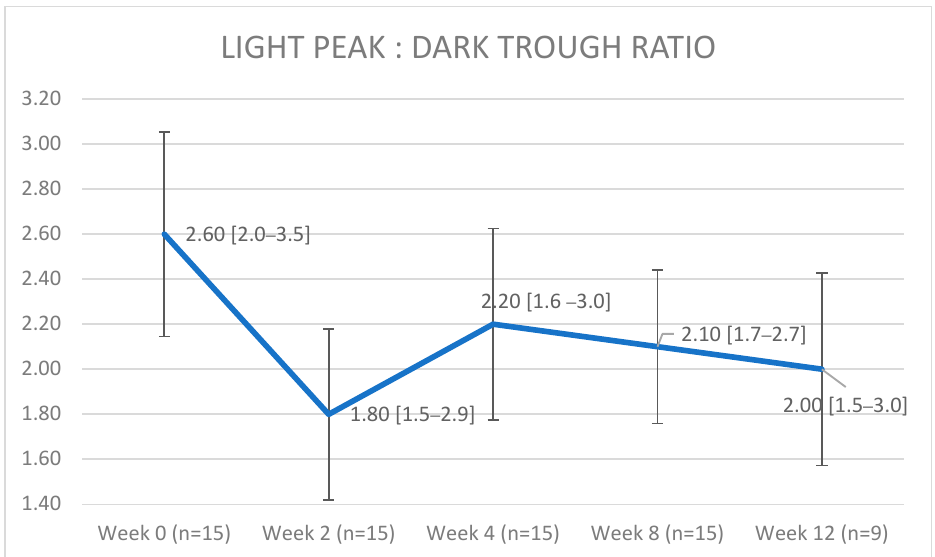
Figure 3. A visual representation of the light peak:dark trough ratios shows a dramatic decrease after the initiation of oncological treatment, followed by an increase, and, lastly, by suggested consolidation. Data are visualized as median (range); the error bars represent the standard deviation.